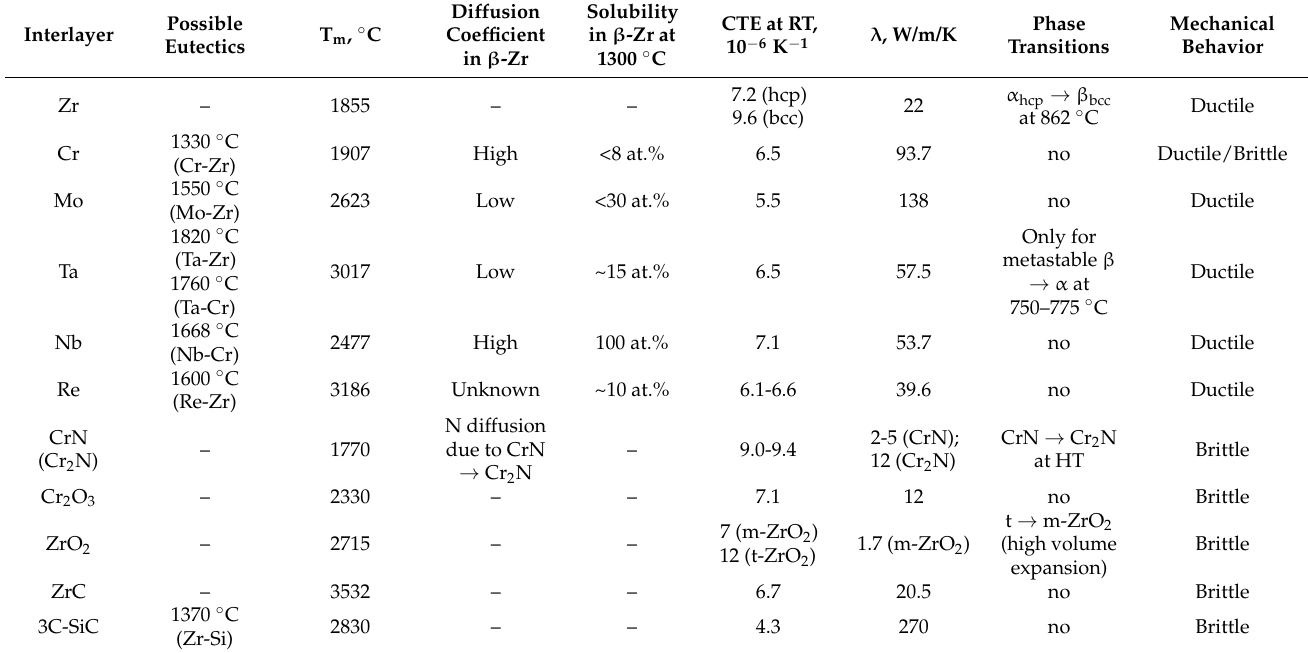
Table 3. Comparison of properties of possible barrier layers between Cr-based coatings and zirconium alloys. Zirconium and chromium are presented for